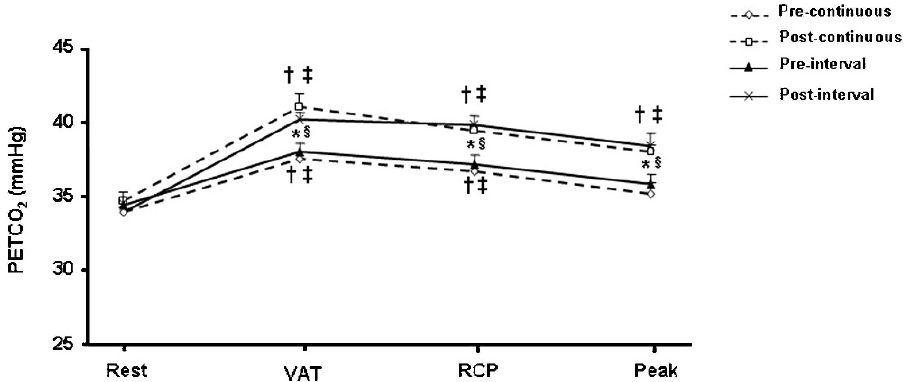
Figure 1 - PETCO 2 response during a graded exercise test in patients with coronary artery disease subjected to either continuous exercise training or interval exercise training. VAT=ventilatory anaerobic threshold; RCP=respiratory compensation point. { p , 0.05 vs. rest (pre- and post-continuous); { p , 0.05 vs. rest (pre- and post-interval); * p , 0.05 vs. post-continuous; 1 p , 0.05 vs.